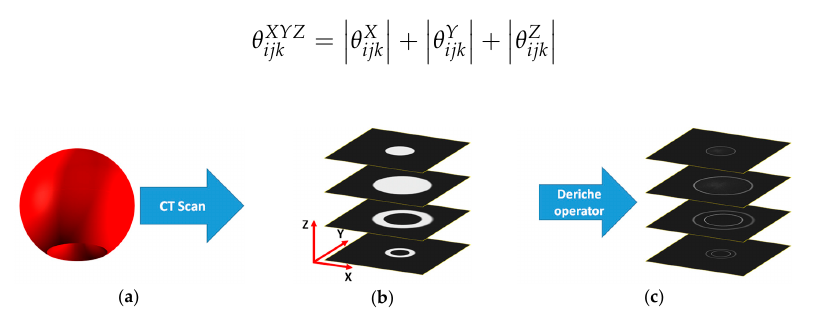
Figure 1. Preliminary edge detection process: ( a ) Scanned part, ( b ) image slices from 3D volume, and ( c ) Deriche edge detection according the three main directions. 2. Sub-voxel refinement: The Deriche and Canny algorithms, as proposed by their authors, define the surface points of the part only according to the coordinates of the voxels that have a